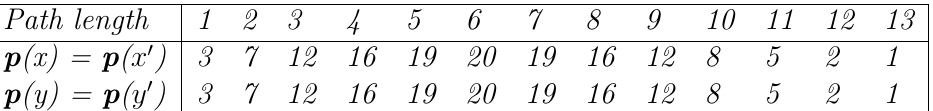
Table 6 : Path vectors for vertices 𝑥 and 𝑦 in tree 𝑇 ′′ and for vertices 𝑥 ′ and 𝑦 ′ in tree 𝑇 ′′′ in Figure 4.